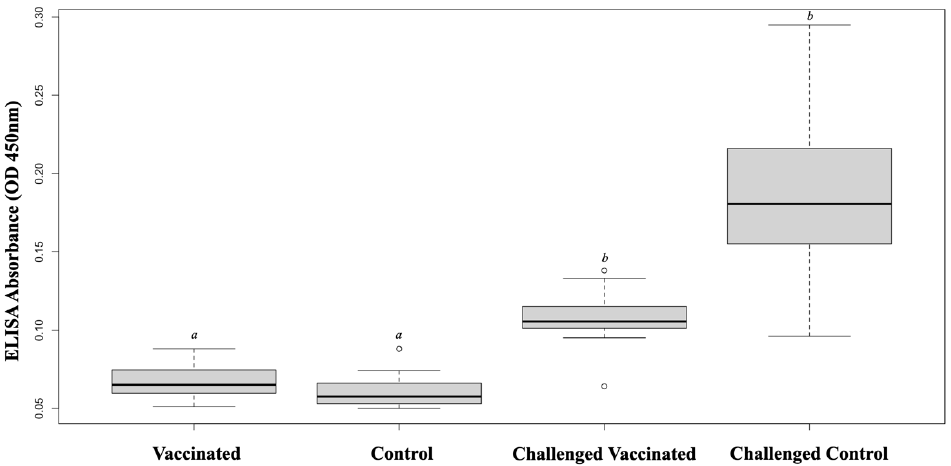
Figure 2. Serum antibody titers against S. iniae determined by ELISA at 8 weeks post-vaccination were not different between the vaccinated and control groups. Both groups showed significantly high antibody levels following a challenge with S. iniae . Significant differences ( p < 0.05) are indicated with different letters.